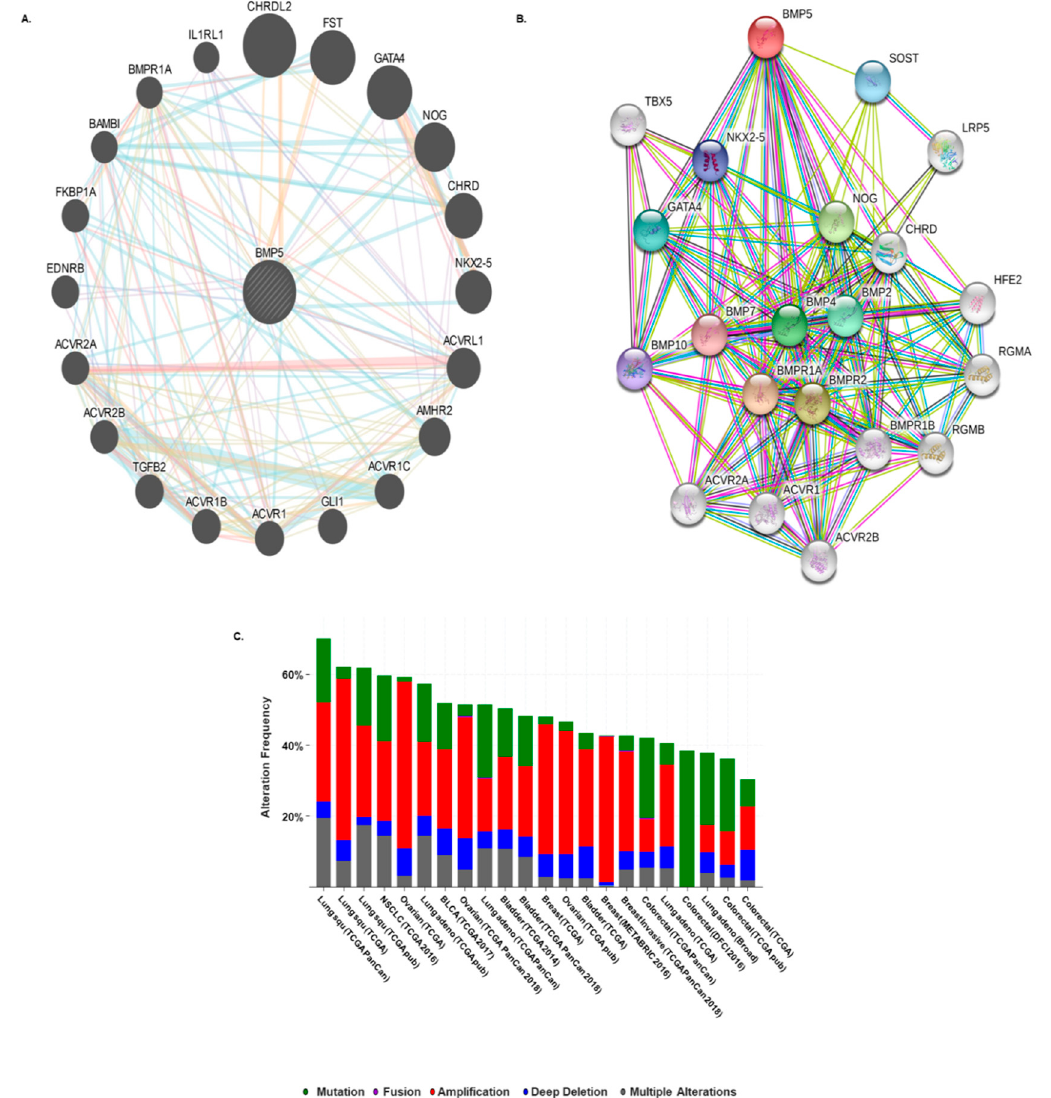
Figure 6. Interaction and co-occurrence functional protein partners of BMP5 . ( A , B ) Predicted structural proteins essential for the functioning of BMP5 generated from GeneMANIA and STRING web. Circles displayed are indicating nodes. Predicted functional partners are shown after considering co-expression, co-localization, genetic interactions, pathways, physical interactions and predicted shared protein domains. ( C ) The alteration frequency of 31 gene signature from GeneMANIA database ( BMP5 , HJV ( HFE2 ), TBX5 , SOST , LRP5 , RGMA , RGMB , BMP2 , BMP4 , BMP7 , BMP10 , FST , CHRDL2 , GLI1 , BAMBI , NOG , CHRD , NKX2-5 , IL1RL1 , GATA4 , TGFB2 , EDNRB , BMPR1A , FKBP1A , AMHR2 , ACVR1 , ACVRL1 , ACVR1B , ACVR2A , ACVR2B , ACVR1C ) was determined using cBioPortal web. Datasets containing > 100 samples per cancer type and alteration frequency of > 20% are shown. Highest alterations were reported in lung squamous carcinoma datasets ( > 60%). The alteration frequency included mutations (green), fusions (violet), amplifications (red), deep deletions (deep blue) and multiple alterations (grey).